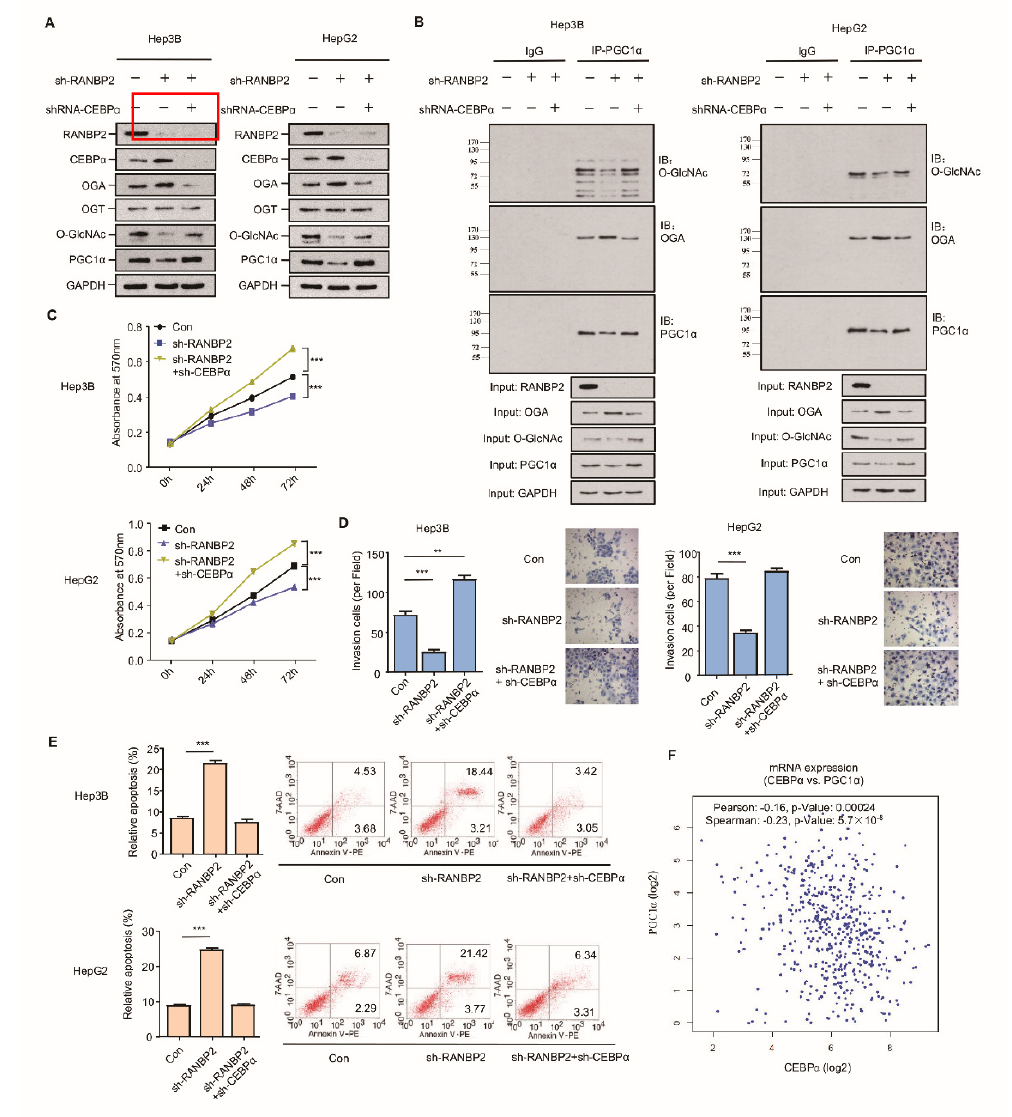
Figure 5. CEBP α is indispensable for RANBP2-associated O-glycosylation imbalance and HCC malignant phenotype in vitro . ( A , B ) Western blotting ( A ) and co-immunoprecipitation (B) results for the O-glycosylation-related factors and HCC oncogenic PGC1 α in response to alterations of RANBP2 and CEBP α levels. Silencing of RANBP2 significantly reduced the total levels of O -GlcNAc, accompanied by augmented OGA. Specifically, the acknowledged oncogene PGC1 α was O- glycosylation-modified, and it was reduced at the protein level under RANBP2 depletion. The above tendencies were largely reversed by CEBP α knockdown. Notably, a protein interaction between OGA and PGC1 α was confirmed. ( C – E ) Proliferation ( C ), apoptosis ( D ), and invasion ability ( E ) of HCC cells in response to alterations in RANBP2 and CEBP α expression. Data are presented as the mean ± SD values from three biological replicates. ** p < 0.01 and *** p < 0.001, t -test. ( F ) CEBP α mRNA expression positively correlated with PGC1 α expression in HCC (linear regression). Data were obtained from the GEPIA